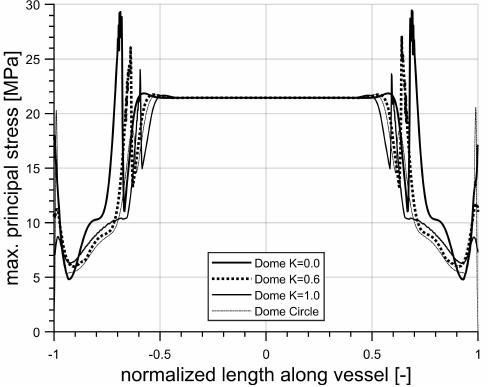
Figure 9. Maximum principal stress in the composite pressure